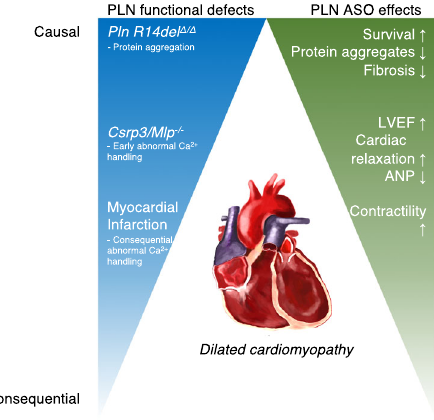
Fig. 5 A graphical study summary showing increased bene fi cial PLN ASO treatment effects with increased contribution of PLN to disease.